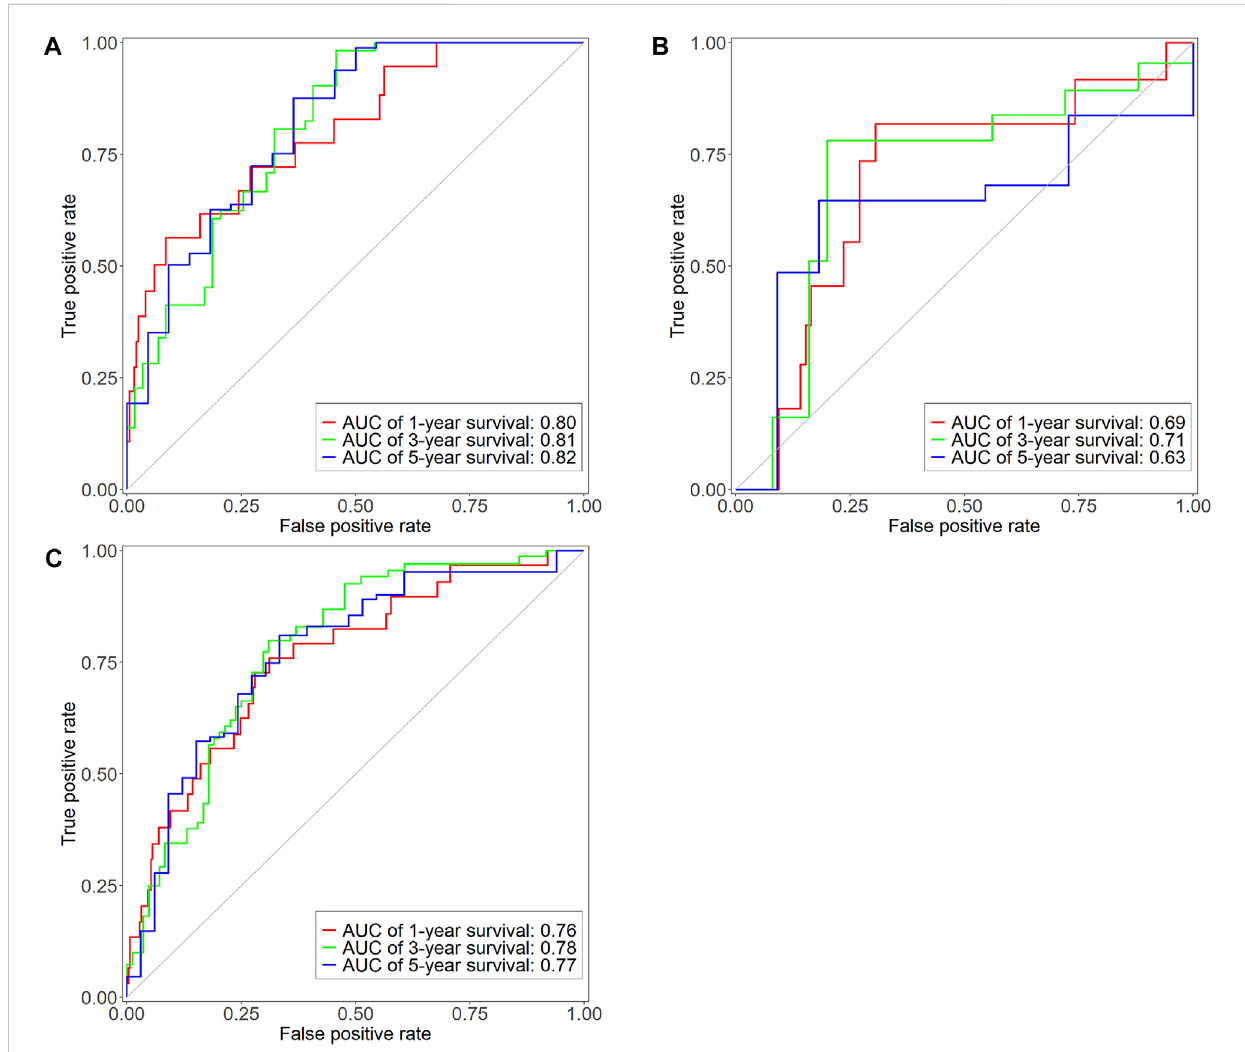
FIGURE 4 Time-dependent ROC curve of training dataset (A) , testing dataset (B) , and entire TCGA dataset (C) . X -axis represents false positive rate, y -axis represents true positive rate. Red, green and blue represent the curves of 1 year, 3 years and 5 years respectively.